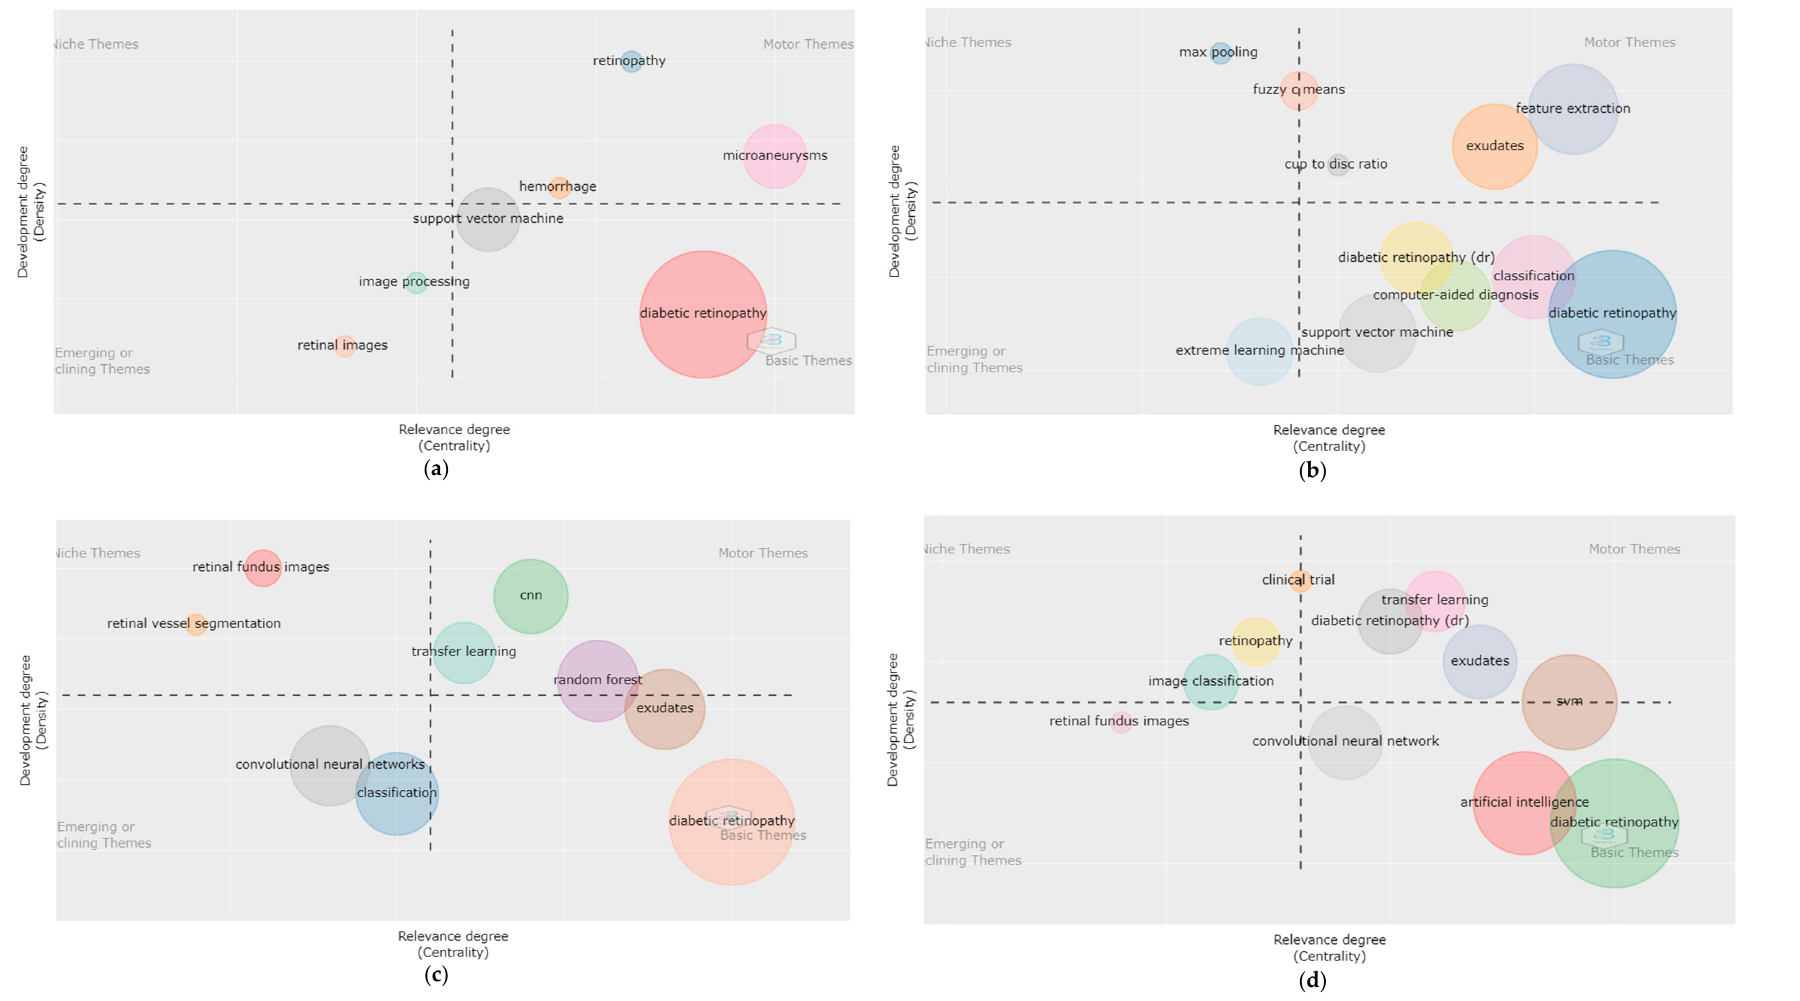
Figure 18. Thematic map of author keywords is plotted with the relevance degree and the work quantity for all four time slices shown in ( a – d ).